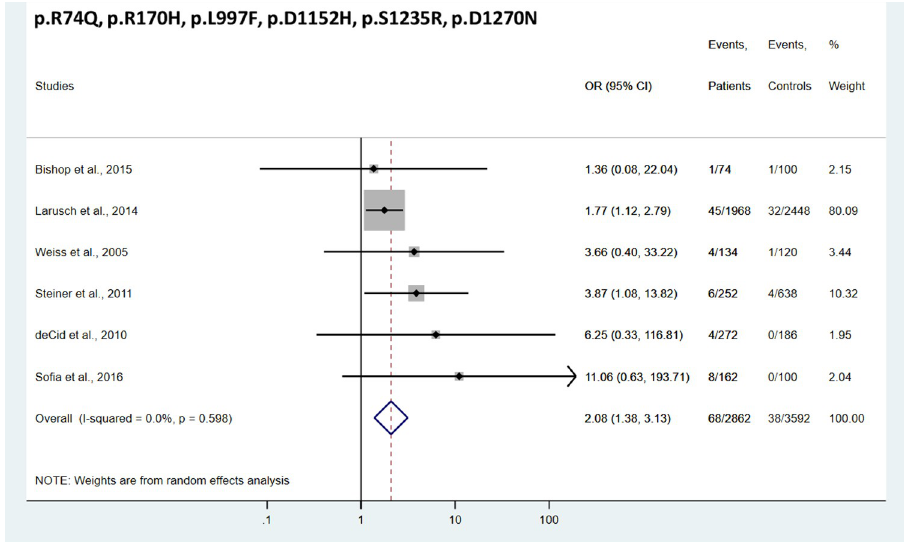
Fig 4. Forest plot showing cumulative odds ratios for chronic pancreatitis risk in subjects carrying CFTR variants p.R74Q, p.R170H, p.L997S, p.D1152H, p.S1235R, and p.D1270N. OR, odds ratio; CI, confidence interval.